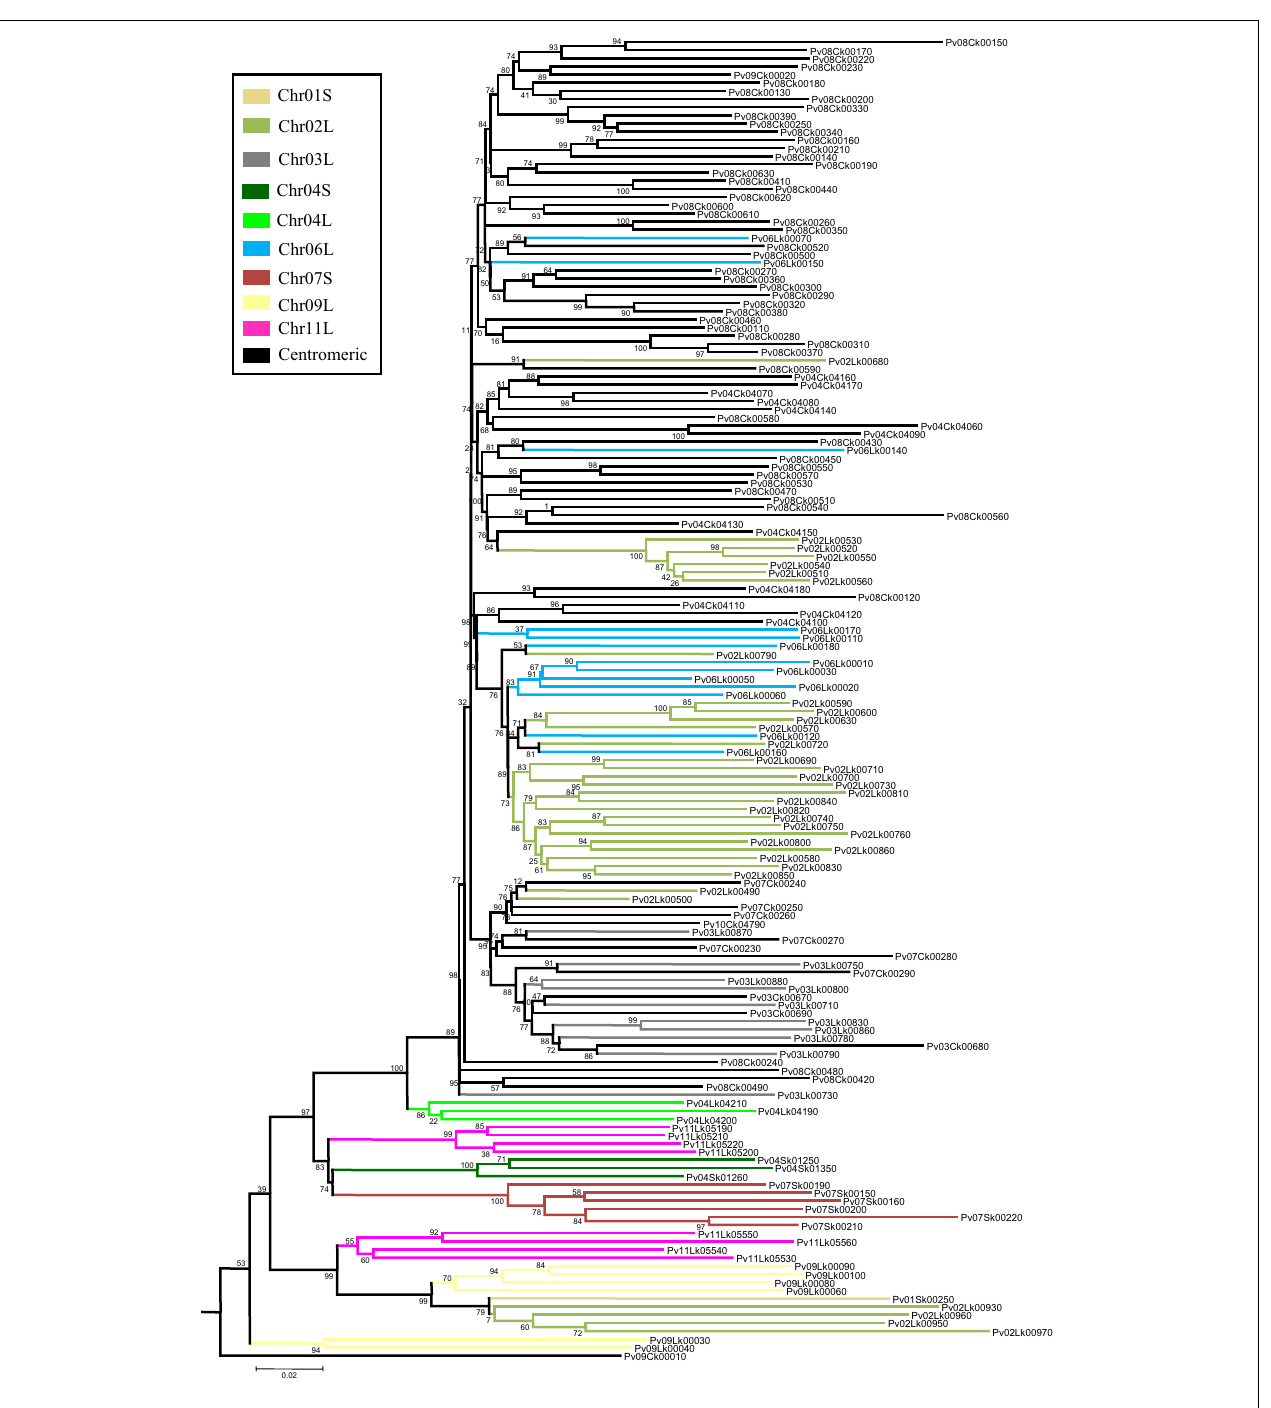
khipu units from Chr02L, Chr03L, and Chr06L interspersed with centromeric khipu units (black), indicating movement of khipu units between subtelomeres and